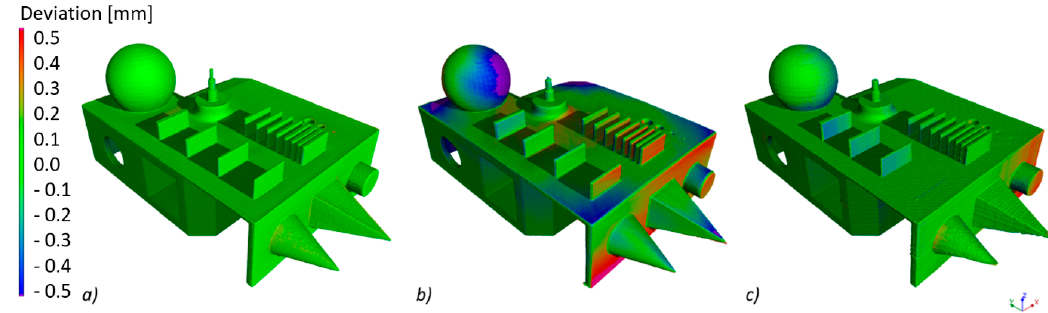
Figure 8. Graphic representation of surface deviation as a result of actual / nominal analysis of ( a ) PA2200, ( b ) PA12 Smooth, ( c ) PA12 Black.